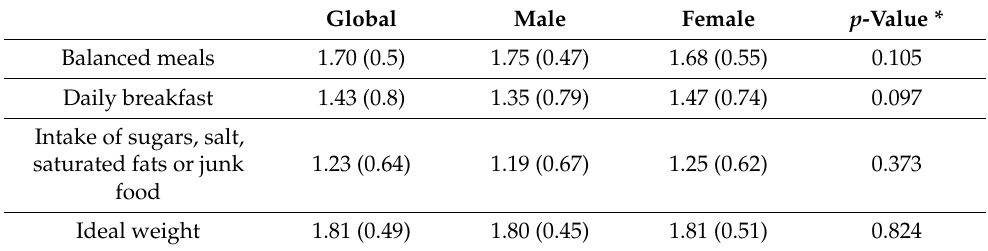
Table 5. Nutrition-related results of the FANTASTIC questionnaire.